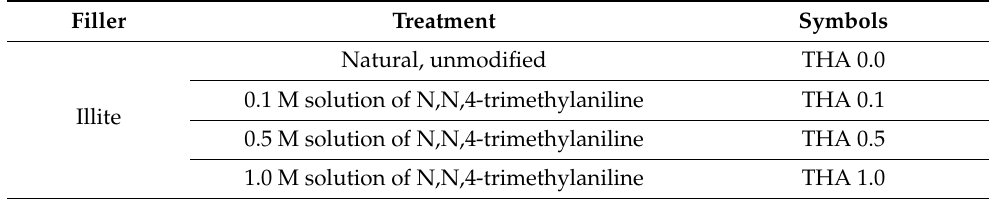
Table 1. Symbols of natural and modified